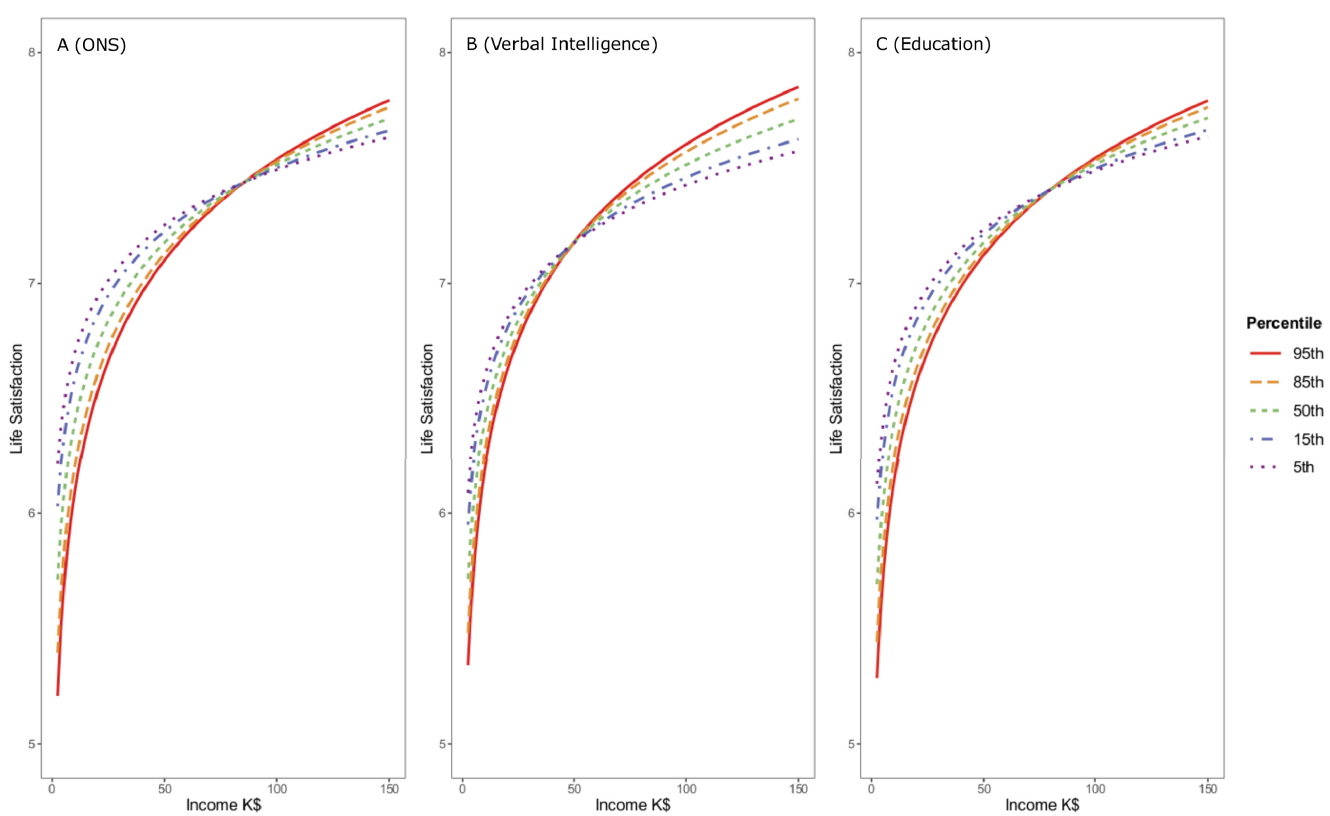
Fig 5. Estimated means of life satisfaction plotted as a function of income (thousands of $) and objective numeracy (panel A) Verbal Intelligence (panel B) and Education (panel C). Each of the moderators remained significant in the model, meaning that each moderator altered the association of income with income